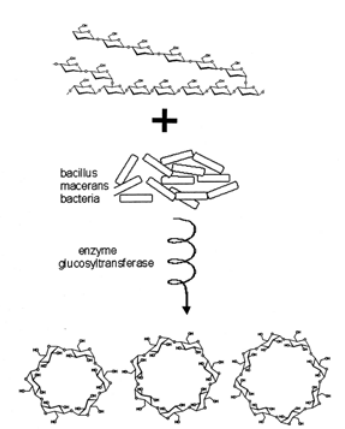
FIGURE 1. Enzymatic conversion of starch to natural cyclodextrins. (Reprinted with permission Wacker Chemical Corp. Adrian MI. USA, modified)